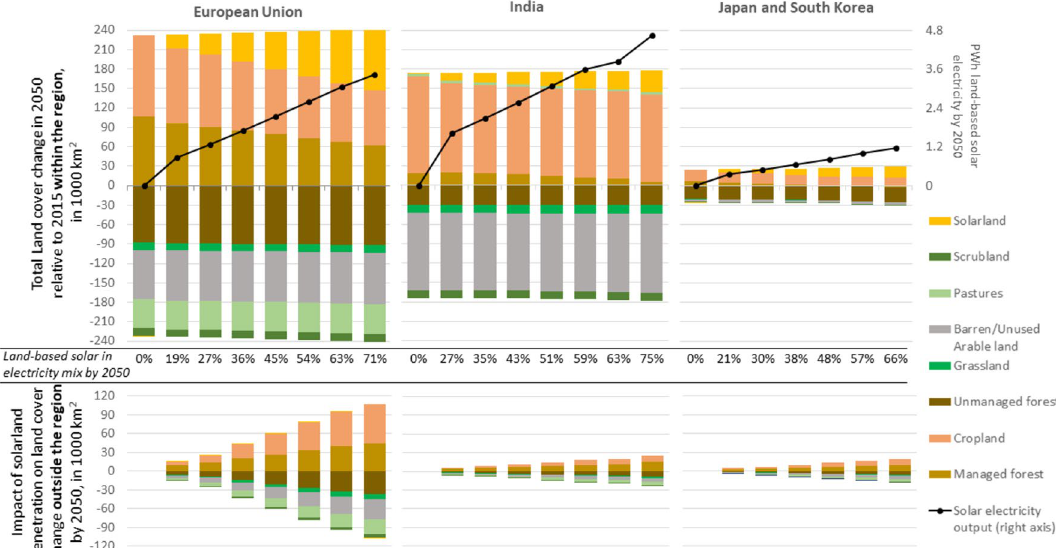
Figure 2. Global land-cover changes by 2050 due to solar expansion, for a range of solar energy penetration levels and for an average efficiency of installed solar modules of 24% by 2050. The upper graphs shows total land cover changes by 2050 relative to 2015 within each region and the lower side shows the land cover changes in the rest of the world (leaking), indirectly driven by the penetration of solarland within the region. Positive land cover changes refer to increases and negative to land cover loss. See Section 3b in the SM for aggregated global land cover changes. Note that land cover changes do not correspond with land use changes: this figure compares total land cover in different scenarios of land-based solar energy penetration, but does not show which specific types of land convert to solarland (or any other type of land). Note that these land cover changes are based on simulated land use decisions driven by economic optimisation. See “Methods” section for more